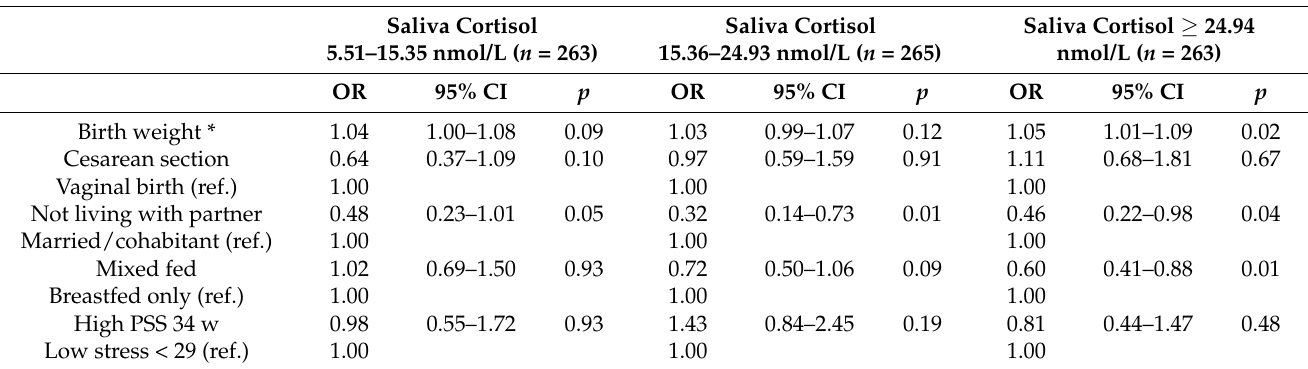
Table 3. Multivariate multinomial logistic regression model analysis of possible associations of early life factors (identified in univariate multinomial regression, p -value < 0.1) and salivary cortisol in 1057 infants at three months of